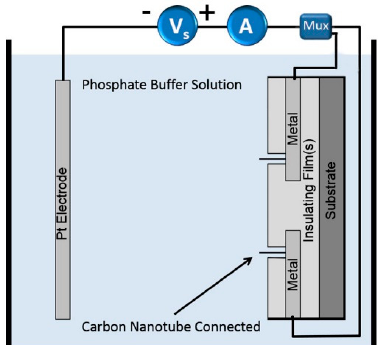
Figure 5. Diagram of experimental setup to measure IV of deposited SWCNTs. A carbon nanotube is selectively connected to the measurement circuit through a multiplexer (Mux).